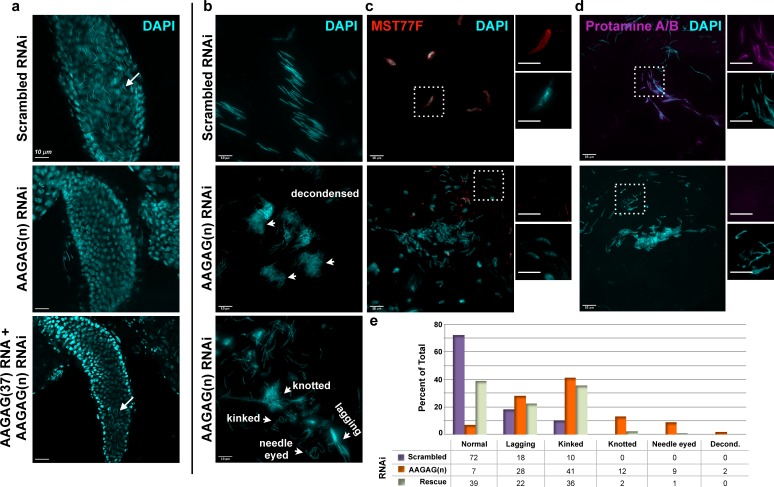
AAGAG RNAi depletion in mitotic germline cysts and spermatocytes (Bam-GAL4 driver) results in severe defects in sperm maturation and protamine deposition.(a) Seminal vesicles (SVs) in testes from 0 to 6 hr old adults; DAPI (DNA) = cyan. Mature sperm nuclei visible as thin, elongated DAPI signals in the scrambled control (top, white arrow) are absent after AAGAG RNAi. Individualized mature sperm (white arrow) are visible in SVs from AAGAG RNAi males that also express AAGAG(37) RNA (partial rescue, 4–7 day old adults). (b) Bundles of elongating sperm nuclei visible in the scrambled RNAi control (top). Defective ‘decondensed’ (middle, white arrowheads), ‘knotted,’ ‘kinked ‘needle eyed’ and ‘lagging’ (bottom, white arrowheads) sperm phenotypes are visible in the AAGAG RNAi but are much less frequent or absent in controls (see e). (c) Transition Protein Mst77F (red) is present on sperm DNA in control RNAi but is largely absent and/or disorganized after AAGAG RNAi (dashed boxes indicate regions in the zoomed images to the right). (d) Protamine A/B (purple) is present on sperm DNA in the scrambled control RNAi but is absent after AAGAG RNAi. Scale bars = 10 µm except for zoomed images in c and d = 8 µm. (e) Quantitation of sperm defects (4–6 day adult testes) associated with AAGAG RNAi depletion, along with AAGAG RNA rescue, compared to scrambled RNAi control.